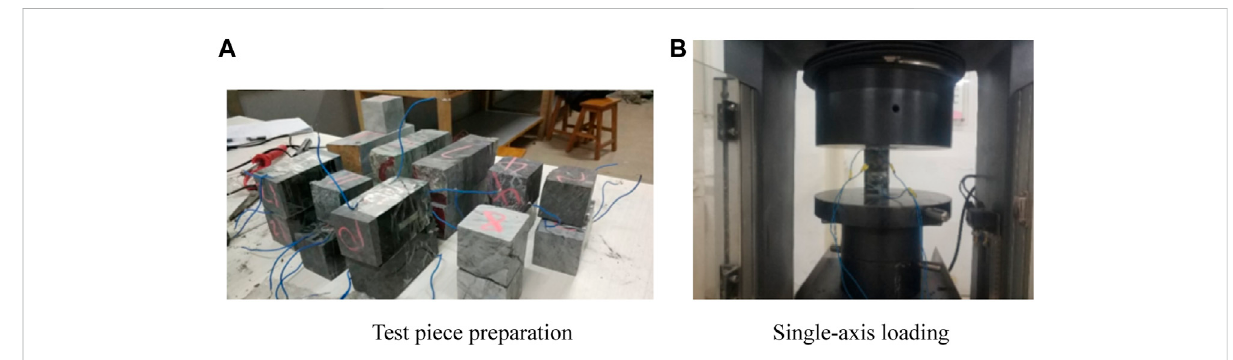
FIGURE 4 Uniaxial compressive test procedure for mineral rock